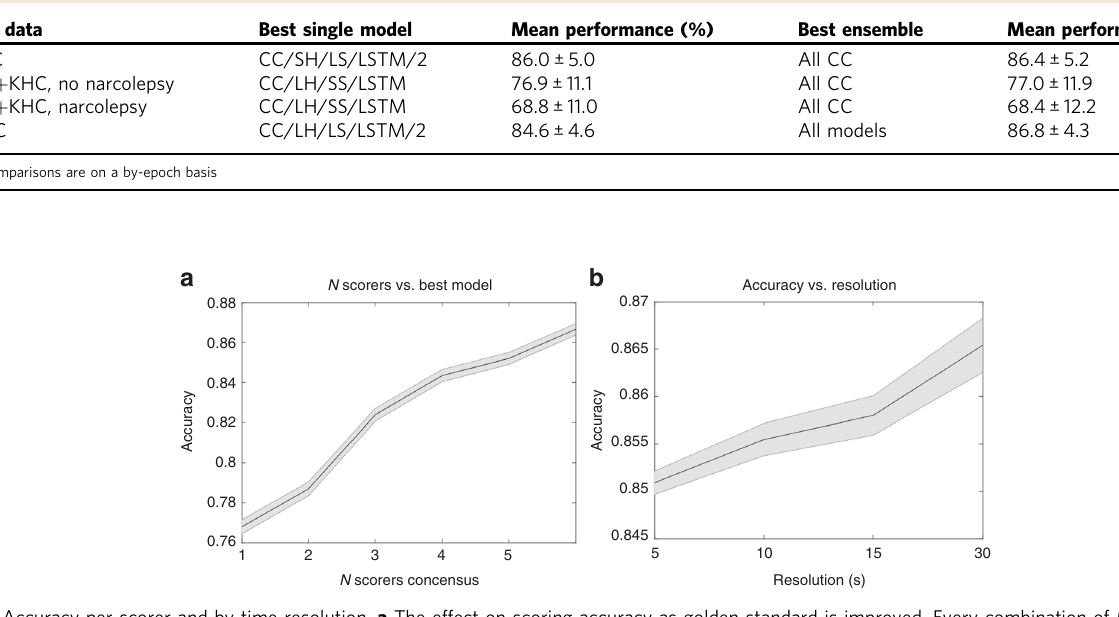
Table 2 Performance of best models, as they are described by Supplementary Table 8, on various datasets compared to the six- scorer consensus